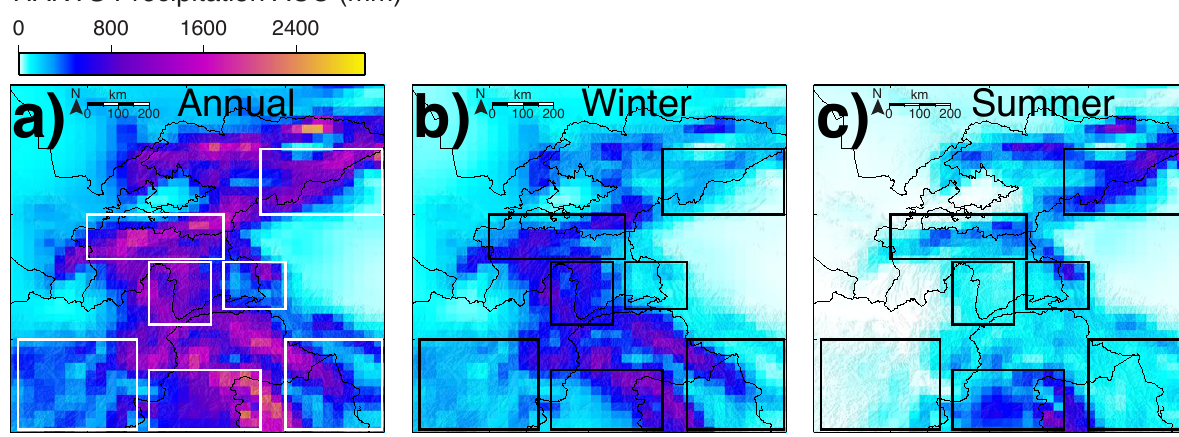
Figure 4. Precipitation distributions of the applied HANTS method for the ( a ) annual, ( b ) winter and ( c ) summer precipitation patterns.